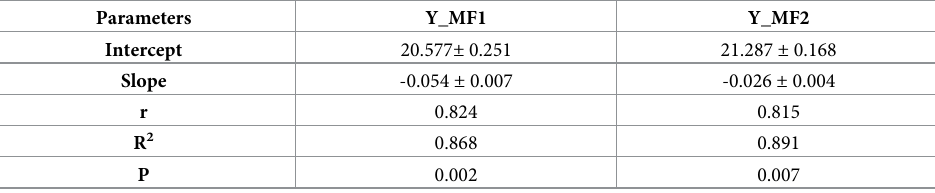
Table 2. Regression analysis of EMG signal